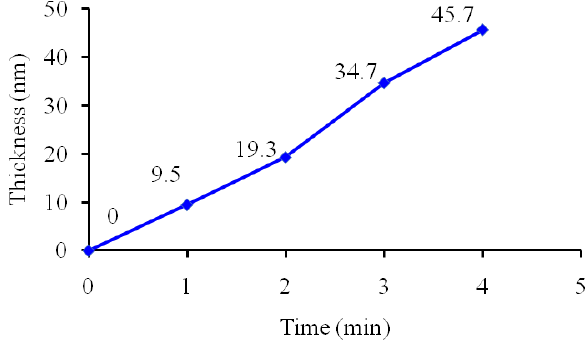
Figure 3. Thickness of the PEO-like film as a function of the plasma polymerization time.